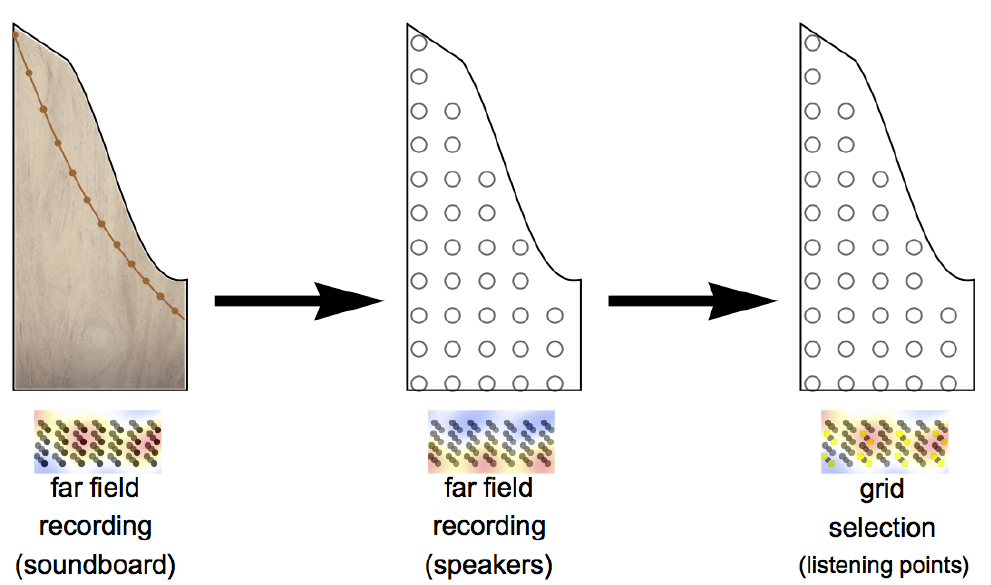
( Θ ) for each loudspeaker Θ l and l , κ a , v , t f 2